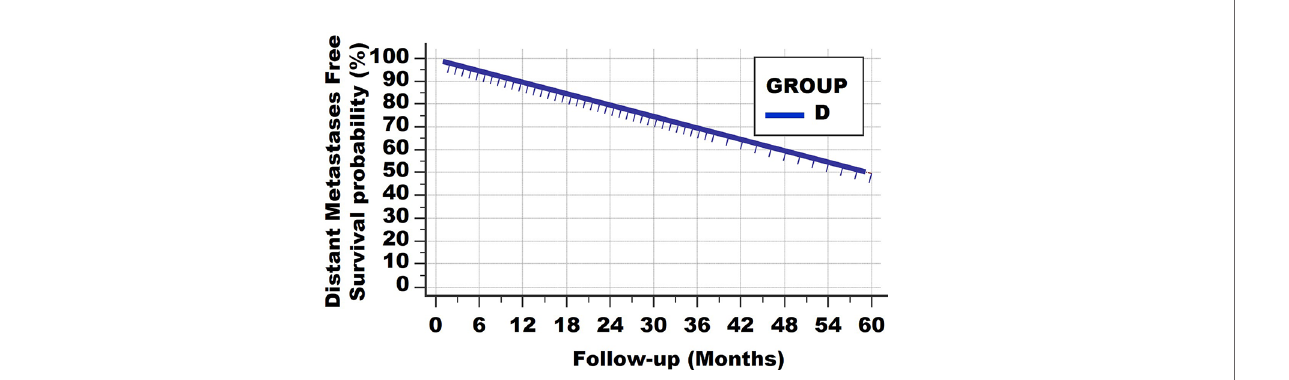
FIGURE 4 | Survival curve type 4. At no point is a horizontal plateau found. This means that all patients had (occult) metastases at the time of diagnosis. However, the growth speeds vary greatly, resulting in continuous deaths from lethal metastatic load.